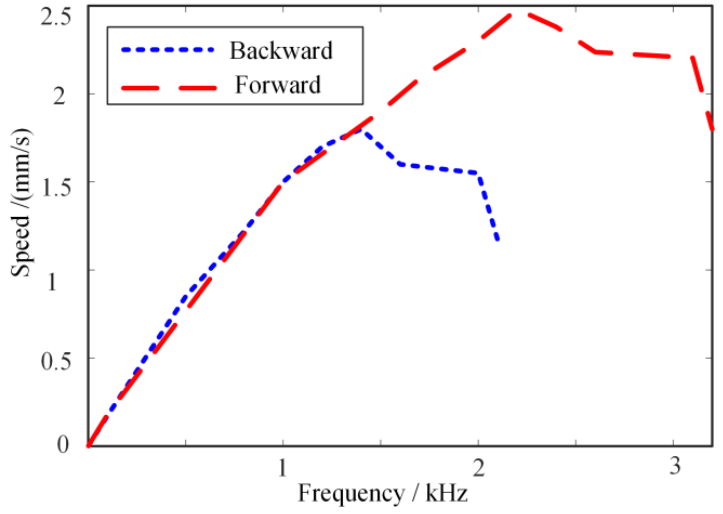
Figure 10. Speed vs. frequency.